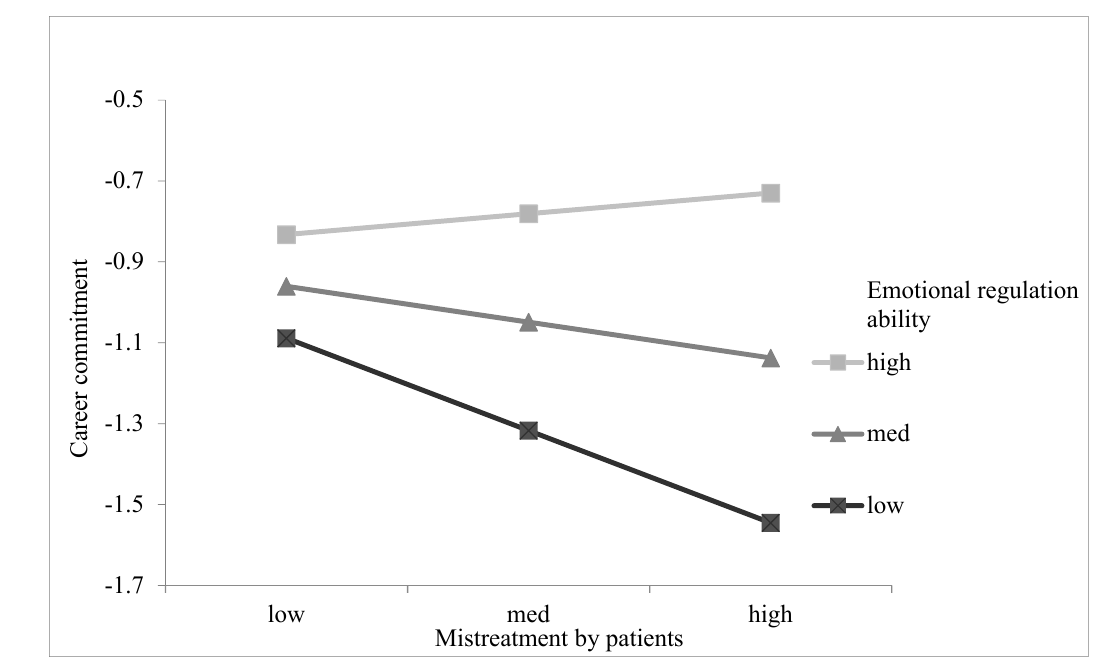
Figure 3. Interaction between mistreatment by patients and emotional regulation ability on workplace well-being.